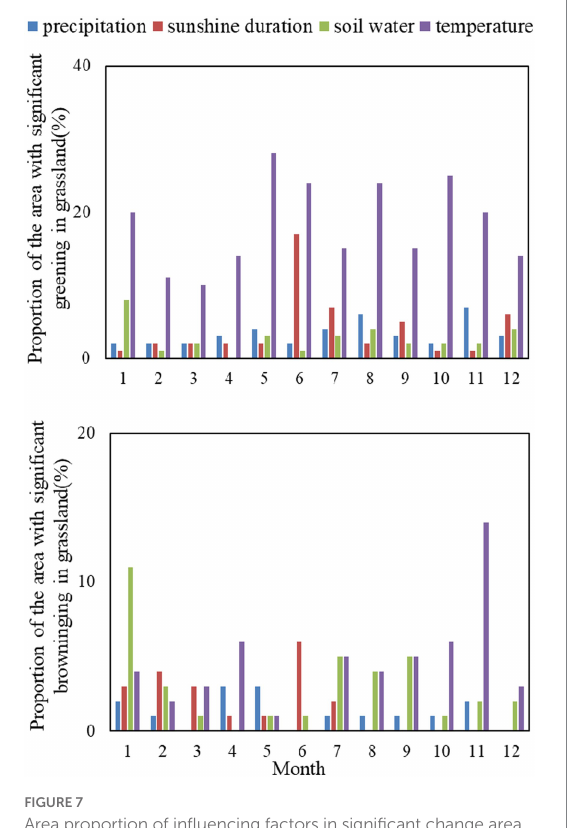
FIGURE 6 Area proportion of influencing factors in significant change area of woodland.